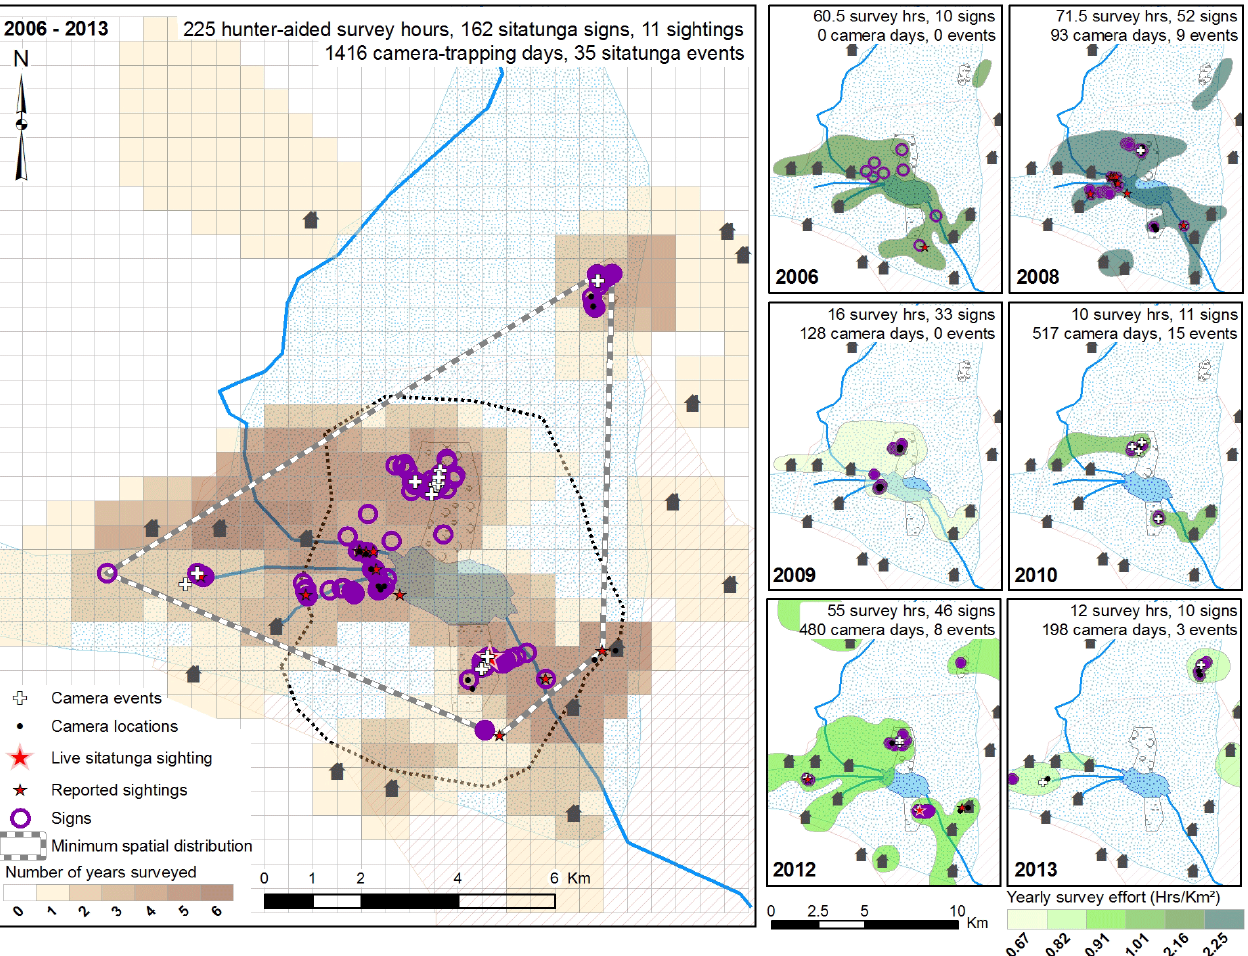
Fig. 2 . Spatio-temporal distribution of survey effort and encounters of sitatunga evidence during hunter-aided surveys and camera trapping